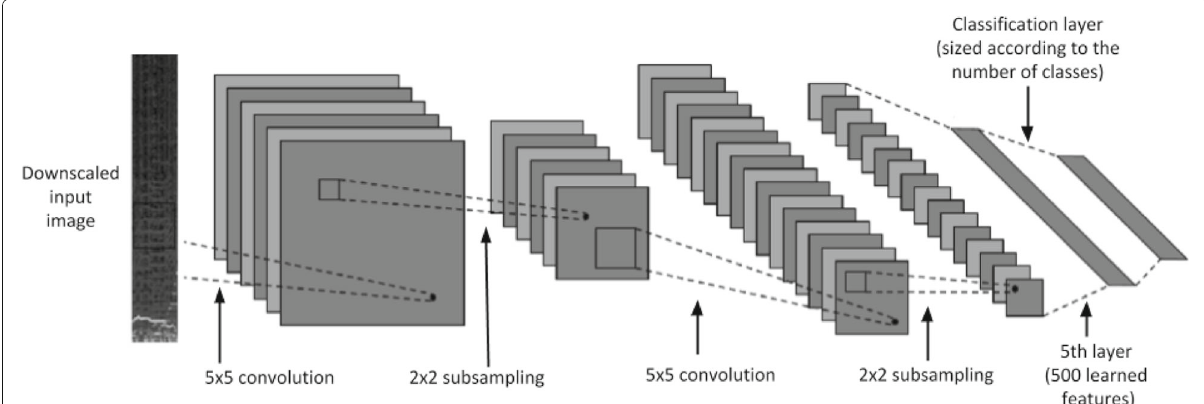
Fig. 3 The deep convolutional neural network architecture (adapted from